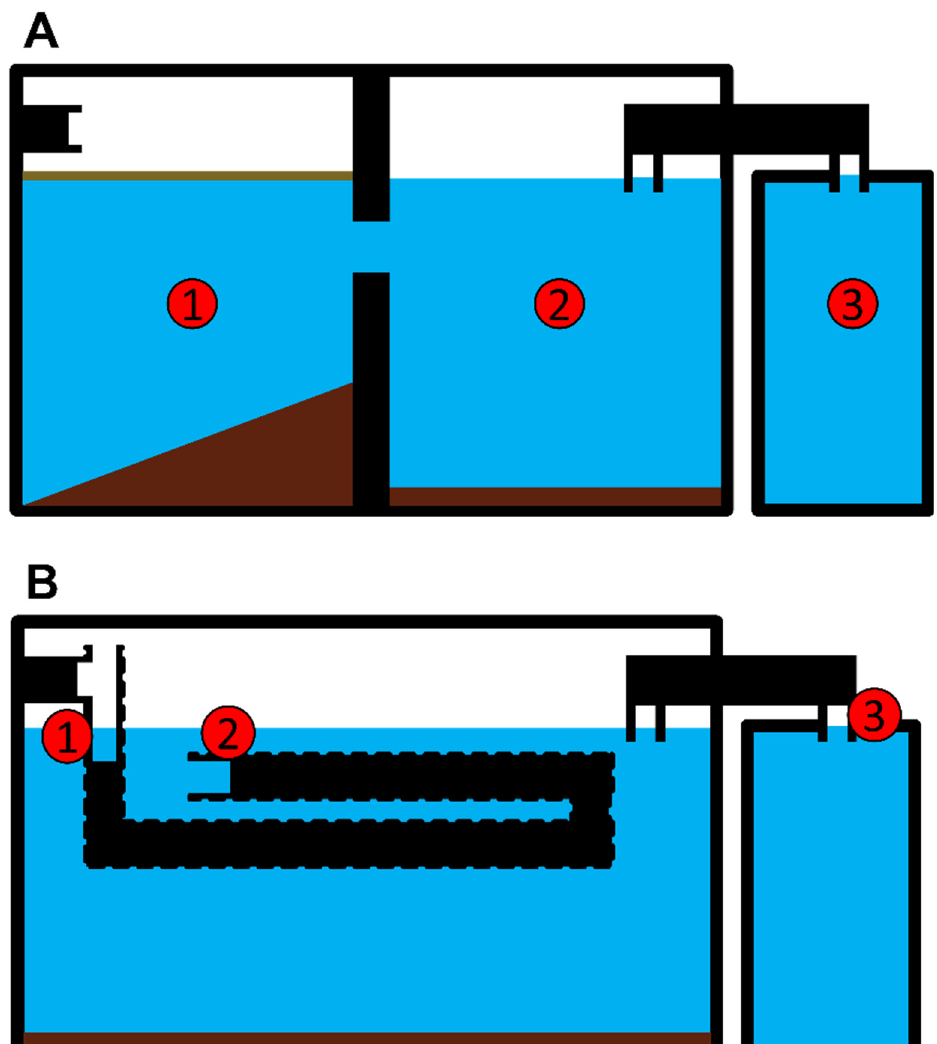
Figure 1. The location of sampling points and internal layouts of OWTSs sampled for metagenomic analysis. ( A ) Conventional two-chambered OWTS design with the influent sampling site located within the first chamber beneath the influent pipe (1), the tank site located within the second chamber (2), and the effluent site (3) located within the effluent holding tank. ( B ) Plug flow type (InnerTube™) OWTS design with the influent sampling site located at the opening of the inner tube (1), the tank site located at the end of the flow tube (2), and the effluent site located at the effluent spray nozzle